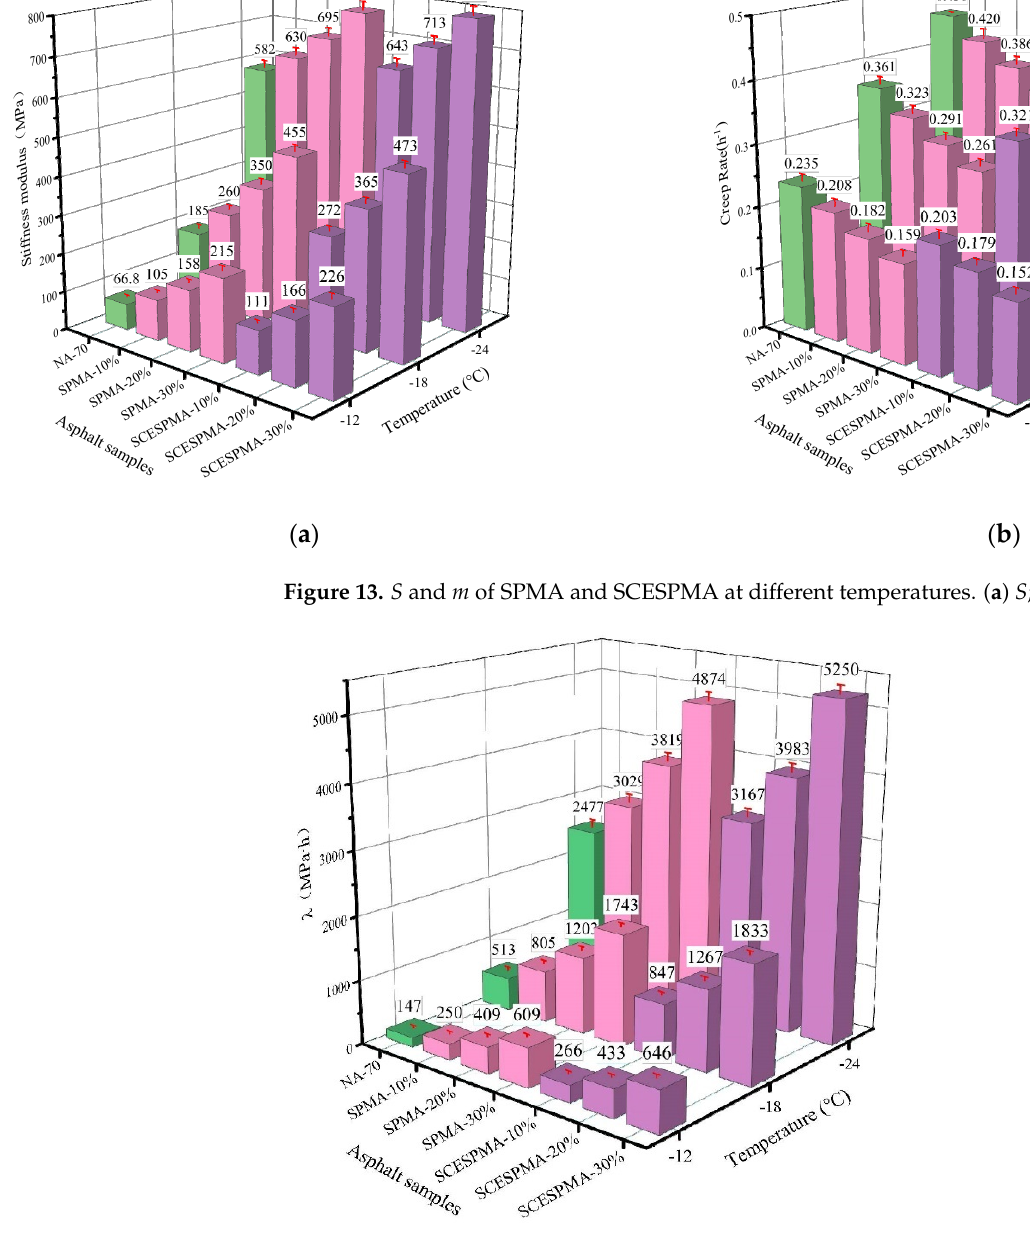
Figure 14. λ of SPMA and SCESPMA at different temperatures.